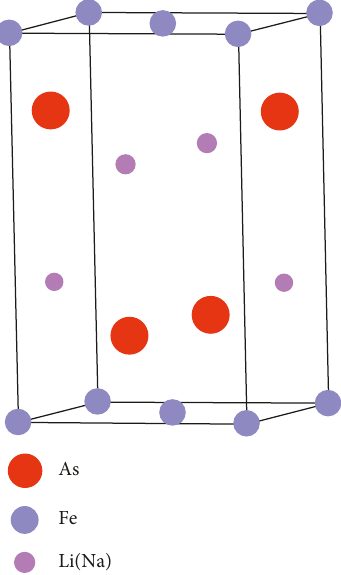
Figure 1: Crystal structure of